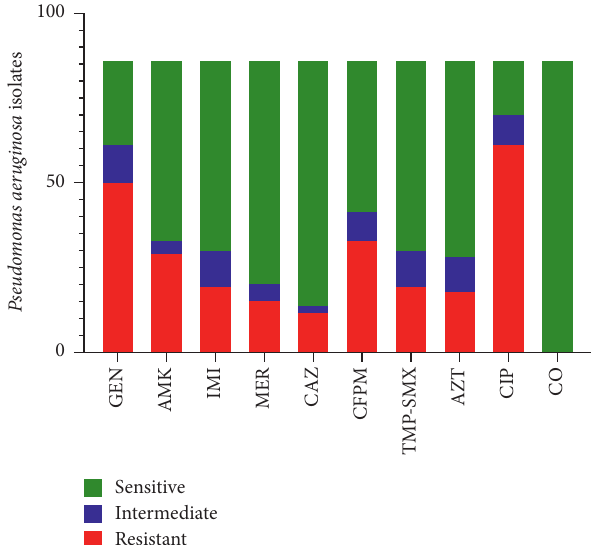
Figure 1: Antibiotic resistance pattern in clinical isolates of P. aeruginosa . IMI: imipenem; MER: meropenem; GEN: gentamycin; CIP: ciprofloxacin; ATM: aztreonam; CPE: cefepime; C: colistin; AMK: amikacin; TMP/SMX: trimethoprim/sulfamethoxazole.